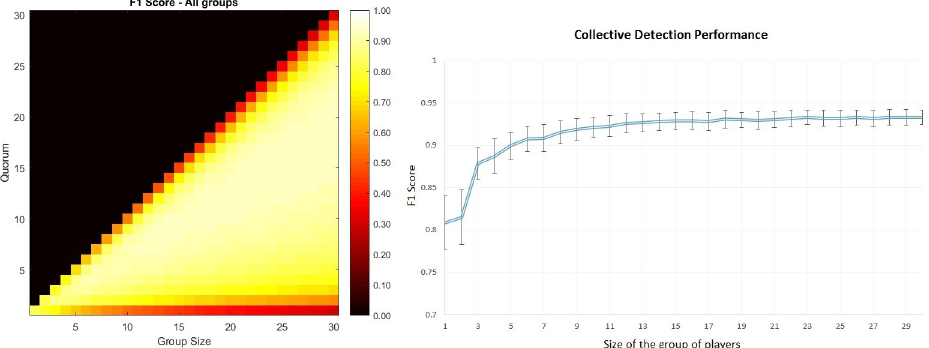
Fig 3. Mean F1 score and collective detection performance. Left. Mean F1 score over the whole image dataset depending on the size of the group of players and quorum. Each combination of group size and quorum was tested 160 times through random selection of gameplays of each image. Right. Mean and standard deviation of overall F1 score corresponding to the best quorum for each group size.